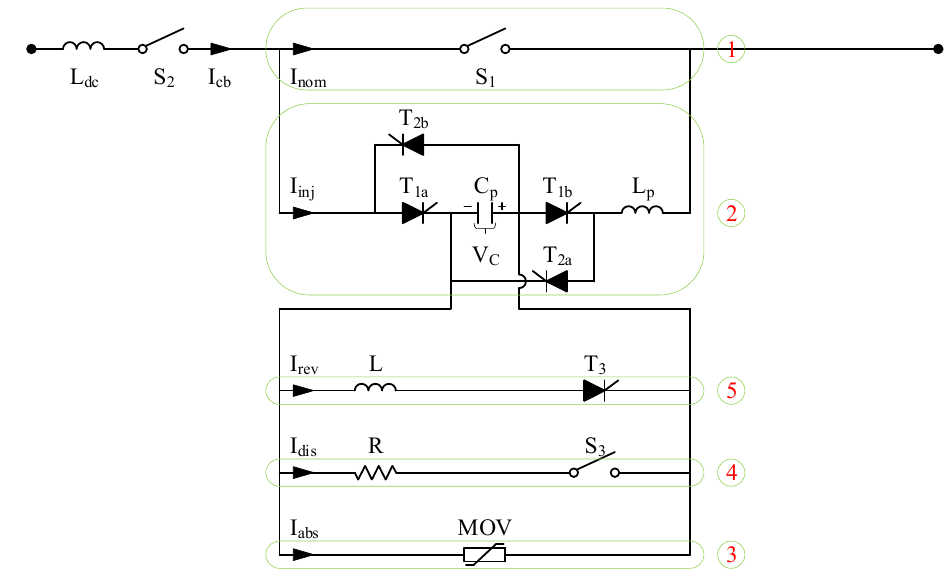
Figure 1. Configuration of the